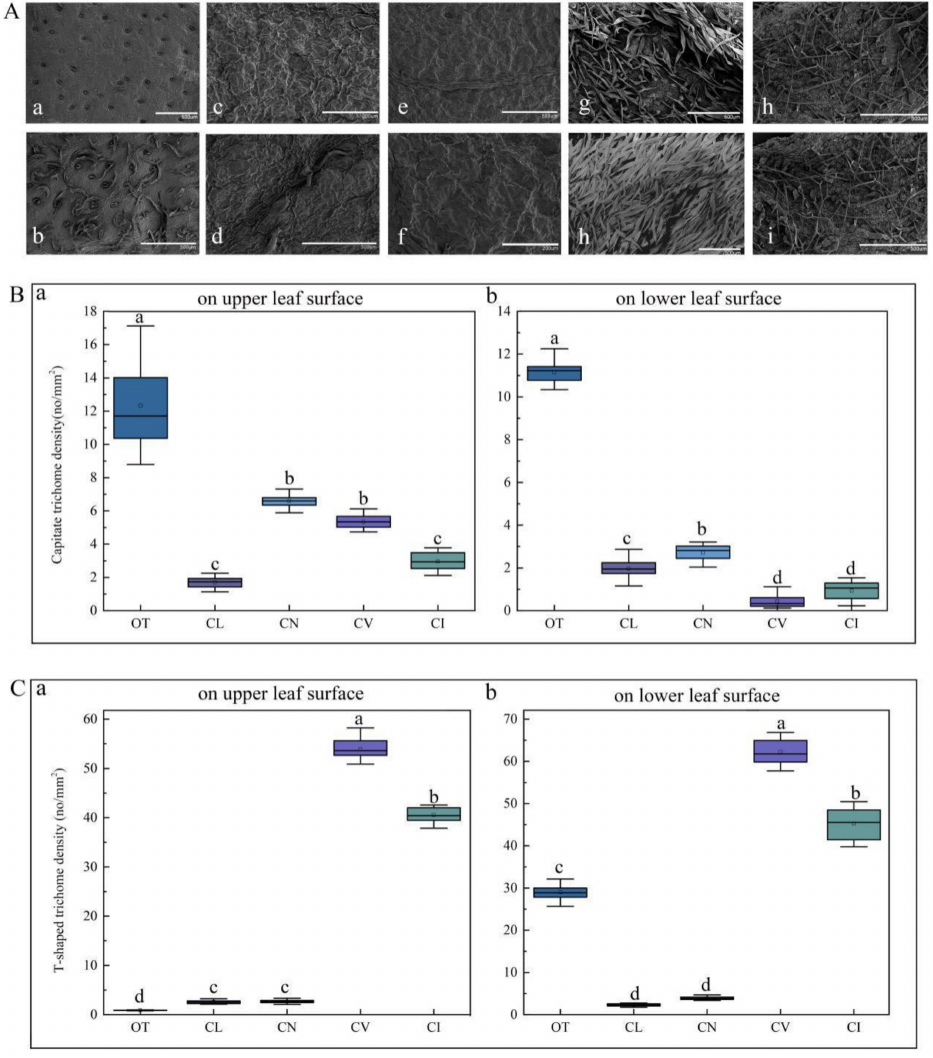
Figure 7. ( A ) The distribution of leaf trichomes on the five wild species by SEM observation: (a) and (b), the distribution of the trichomes of O. taihangensis on the upper surface and lower surface, (c) and (d), the distribution of the trichomes of C. lavandulifolium on the upper and lower surface; (e) and (f), the distribution of the trichomes of C. nankingense on the upper and lower surface; (h) and (g), the distribution of the trichomes of C. vestitum on the upper and lower surface; (i) and (j), the distribution of the trichomes of C. indicum on the upper and lower surface. The density of ( B ) the capitate and ( C ) T-shaped trichomes on the leaves of the five wild species. The di ff erent letters (a–d) in the same column of ( B , C ) represent the significance among the di ff erent species, according to Tukey’s test ( p <